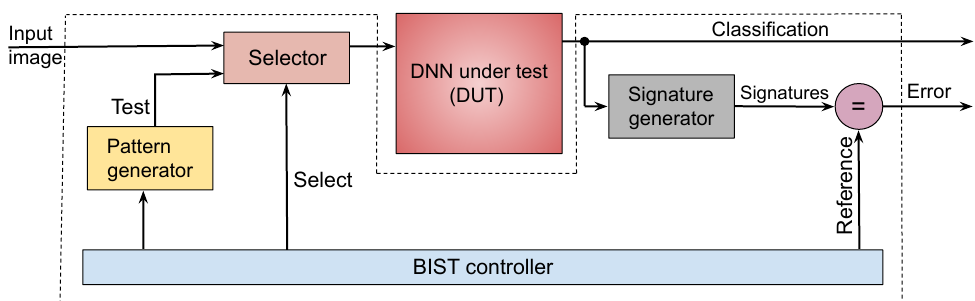
Figure 3. Proposed BIST